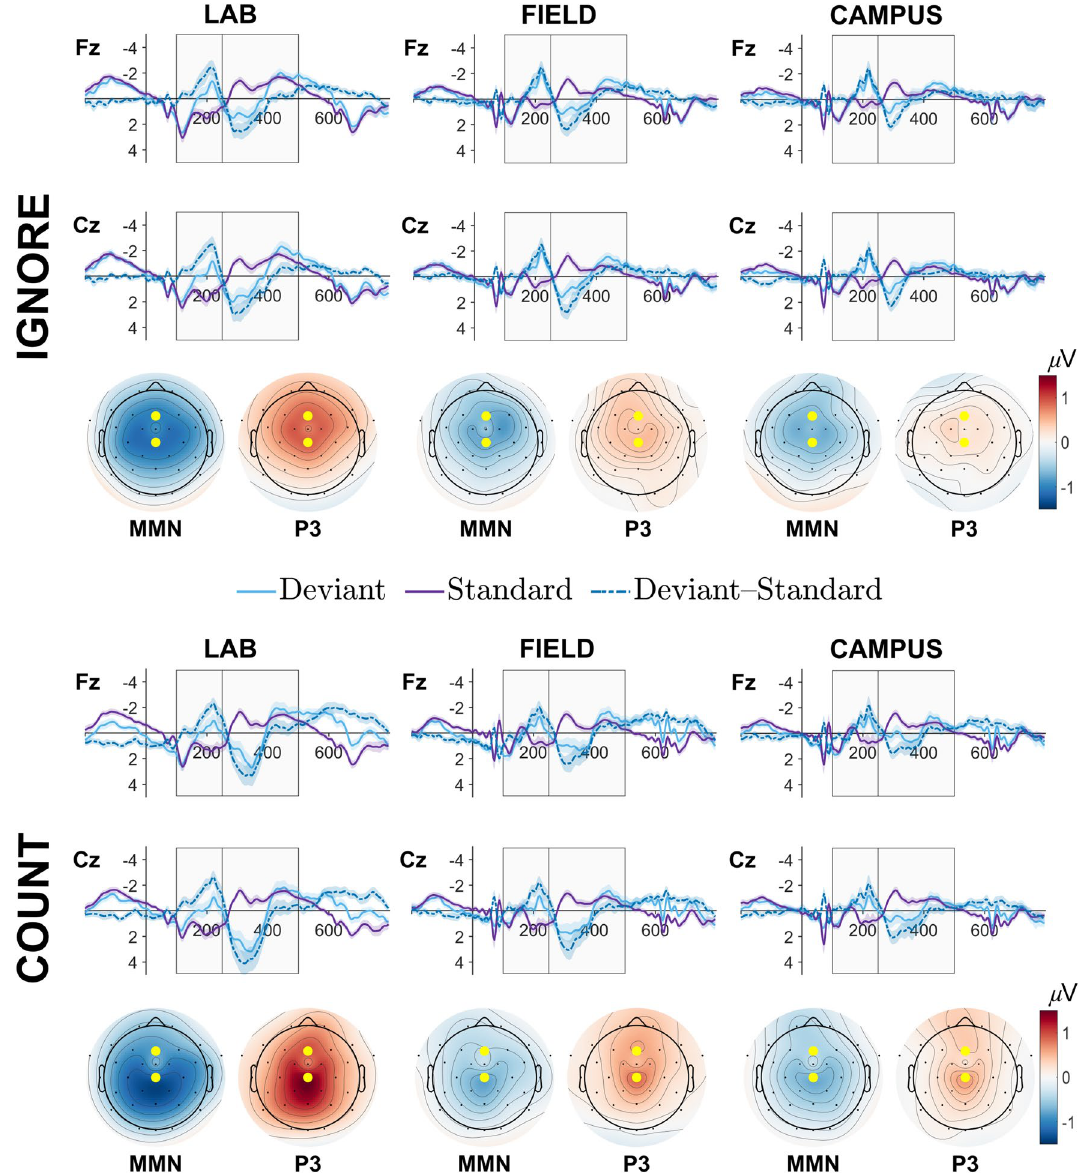
Figure 3. Grand average event-related potentials (ERPs; solid lines), difference waveforms (broken lines) and topographies for Ignore (top panel) and Count (bottom panel) tasks across Lab (left column), Field (middle column), and Campus (right column) conditions. Light blue waveforms depict ERPs evoked by deviant stimuli; purple waveforms depict ERPs evoked by standard stimuli. Broken lines indicate the difference in mean voltage ( µ V) between deviants and standards. Topographies depict mean voltage differences ( µ V) averaged across the two time-windows of interest (MMN = 100 – 250 ms; P3 = 250 – 500 ms). Yellow dots indicate electrode locations for plotted ERPs (upper = Fz, lower =